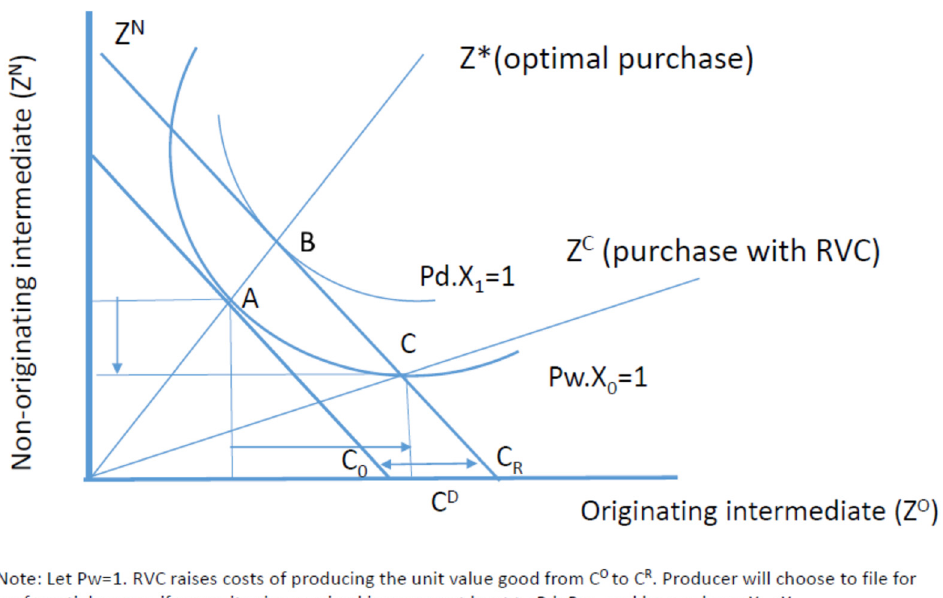
Figure 3. Distortionary costs of a binding regional value content (RVC).